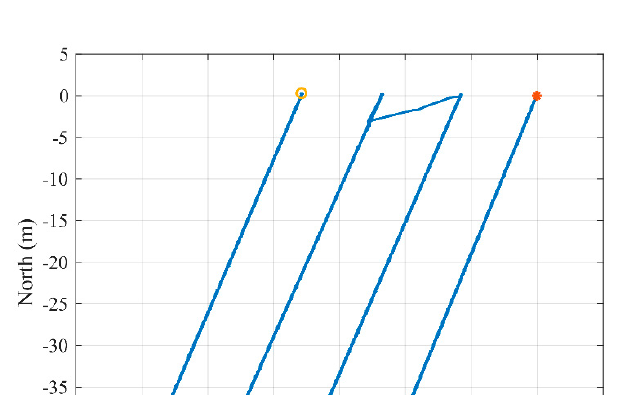
Figure 5. Experiment mobile carrier and the equipment.